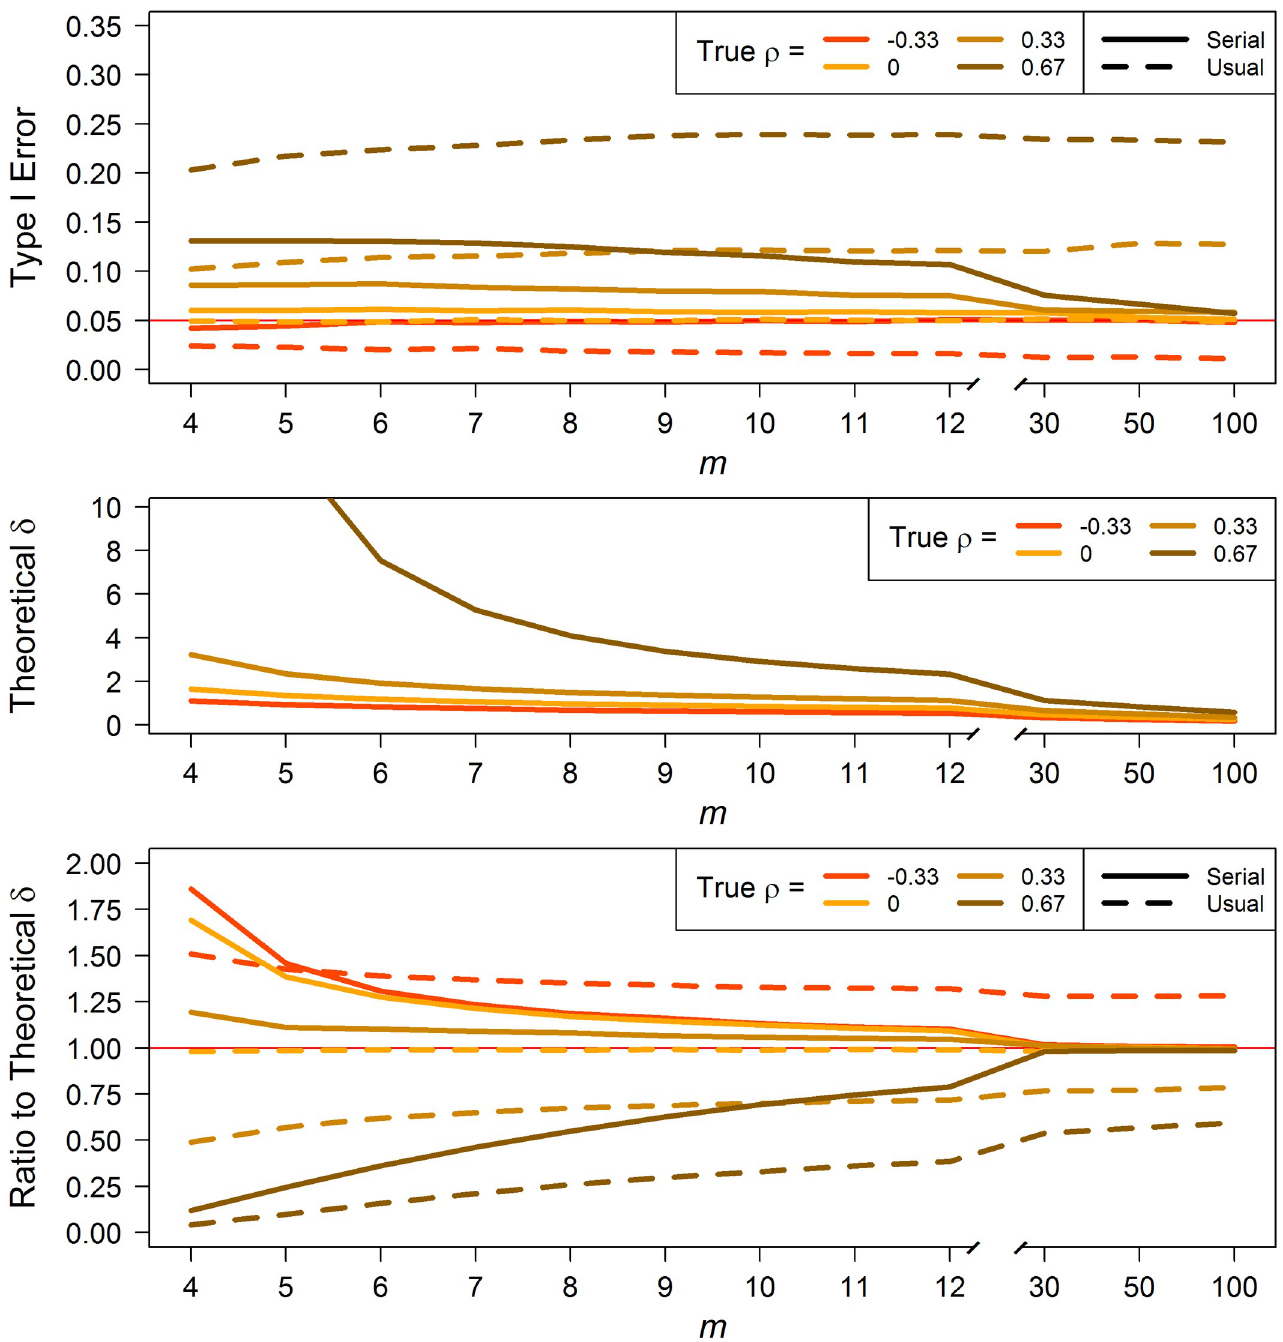
Fig 3. Paired t -test for level-change. Type I error (top) and theoretical effect size, δ , computed using Eq 8 for 80% power with a one-sided 5% significance level test for a given m (middle). Ratios (bottom) of serial and usual δ (estimated from simulation) to the theoretical δ under same conditions as the theoretical δ . https://doi.org/10.1371/journal.pone.0228077.g003 ( m � 12), but approach nominal by m = 30. Type I errors for usual t -tests (except when ρ = 0) are only better than the serial tests for small m ( m � 8), thereafter, usual’s Type I errors tend to diverge from nominal level.